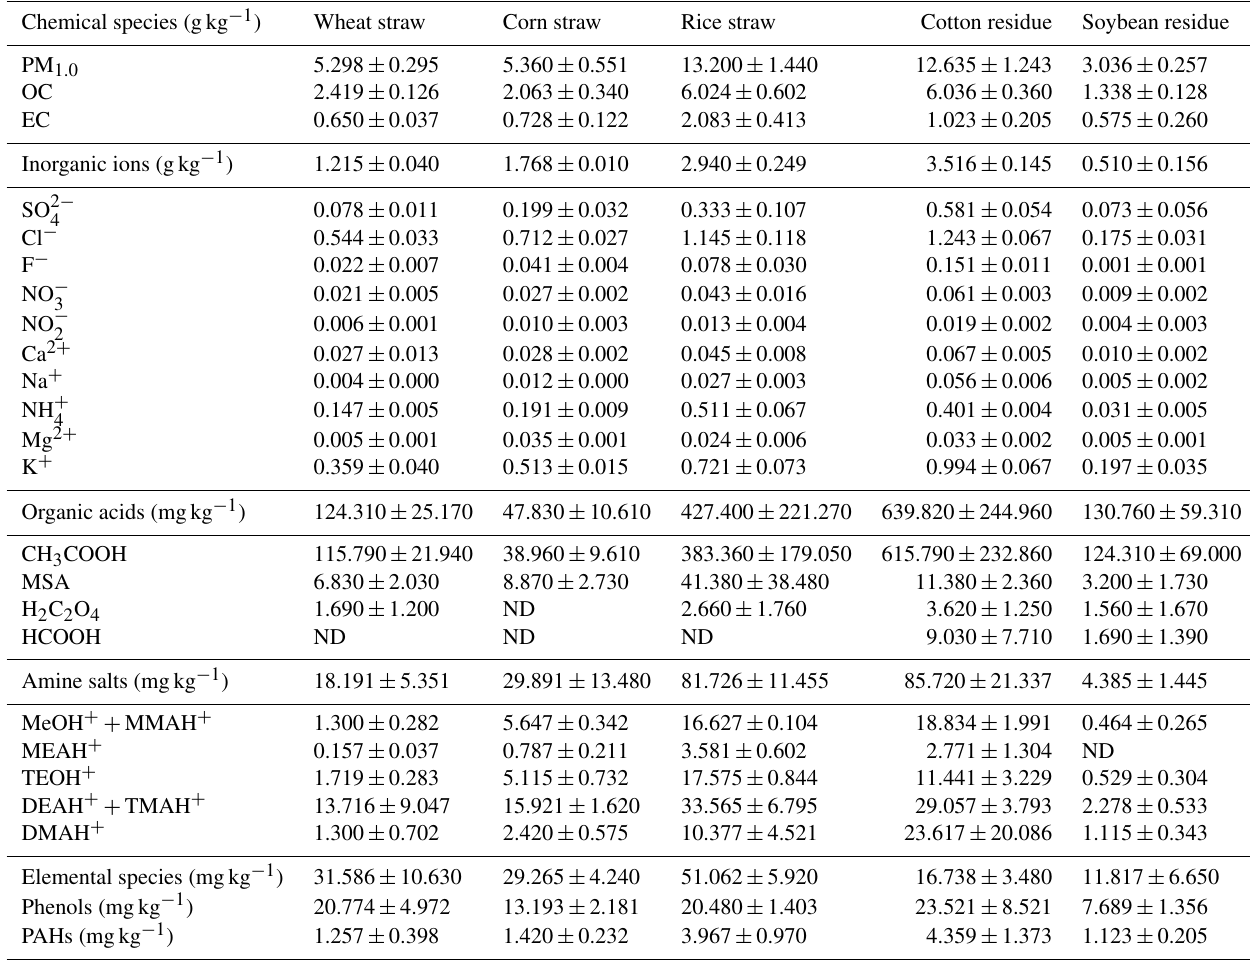
Table 2. Emission factors of particulate chemical species in smoke PM 1 . 0 from agricultural residue burning (mean value ±